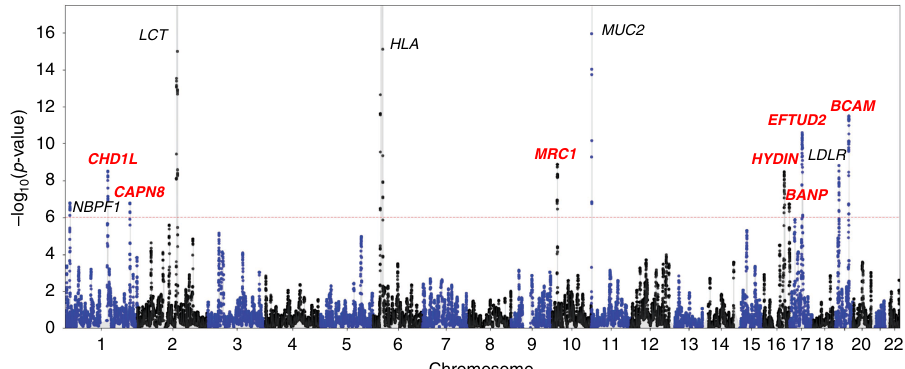
Fig. 4 Genome-wide scan for recent positive selection in the UK Biobank dataset. Manhattan plot with candidate gene labels for 12 loci detected at genome-wide signi fi cance (adjusting for multiple testing, approximate 1-sided DRC 50 p < 0.05/52,003 = 9.6 × 10 − 7 ; dashed red line). The DRC 50 statistic of shared recent ancestry within the past 50 generations was computed using 487,409 samples within the UK Biobank cohort. FastSMC detected 5 loci known to be under recent positive natural selection (gene labels in black) and 7 novel loci (in red). The corresponding p -values are reported in Supplementary Table